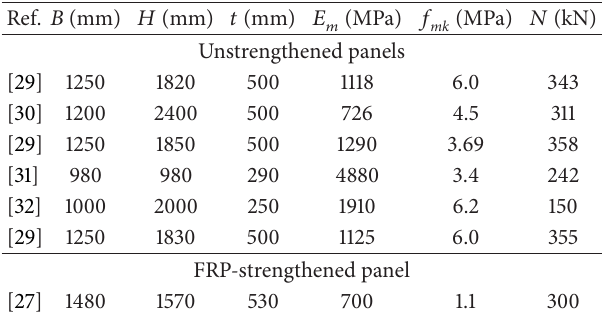
Table 1: Characteristics of the literature